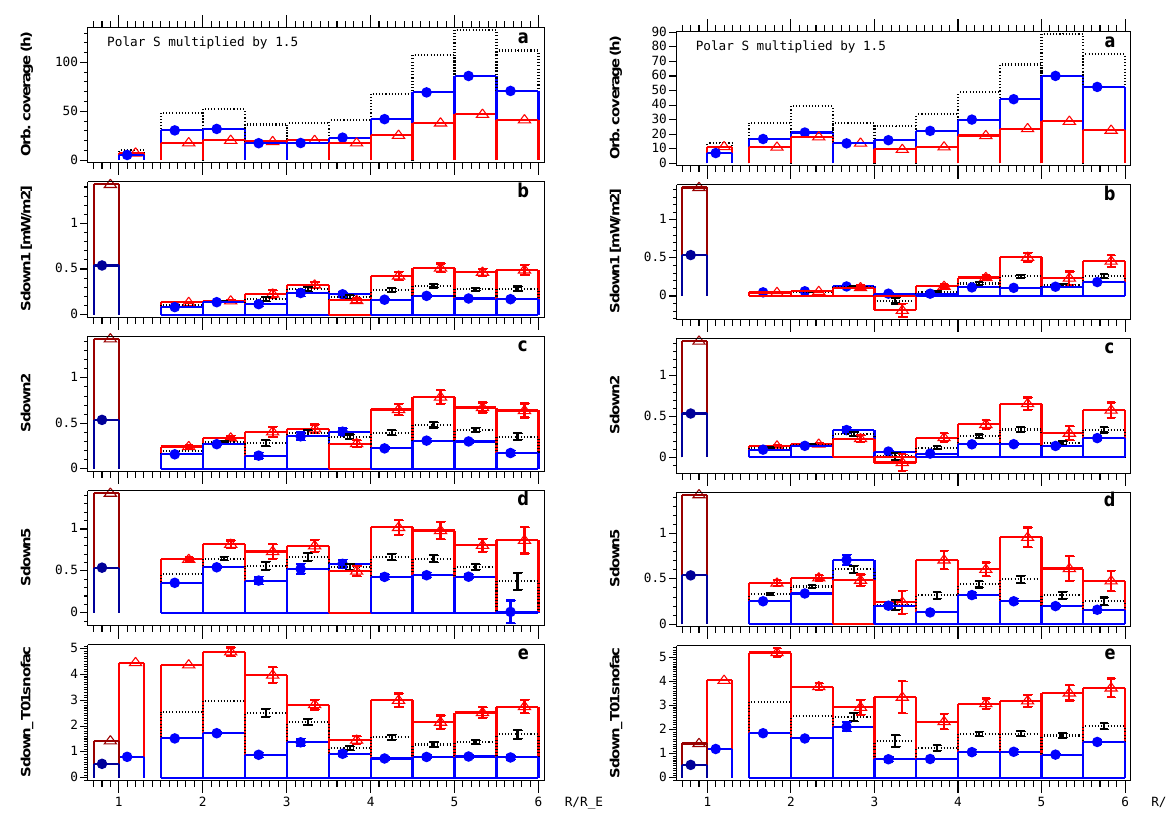
Fig. 4. Same as Fig. 2, but decomposed into cases where Polar ionospheric footpoint is in darkness (left) or illuminated by the Sun (right).